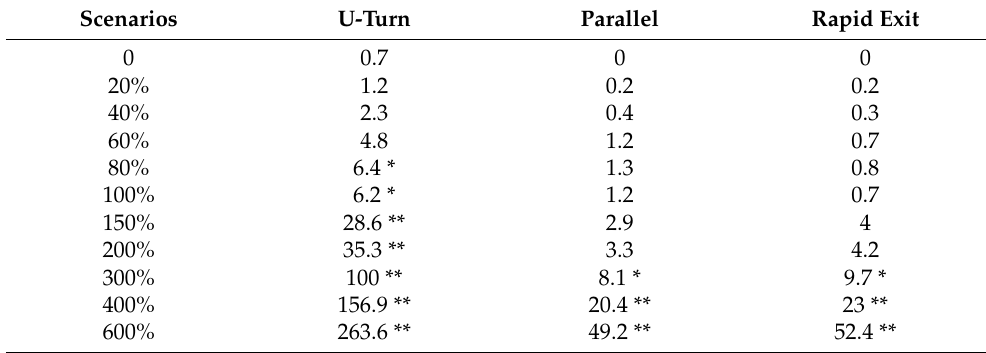
Table 14. Practical capacity (total delay per AC